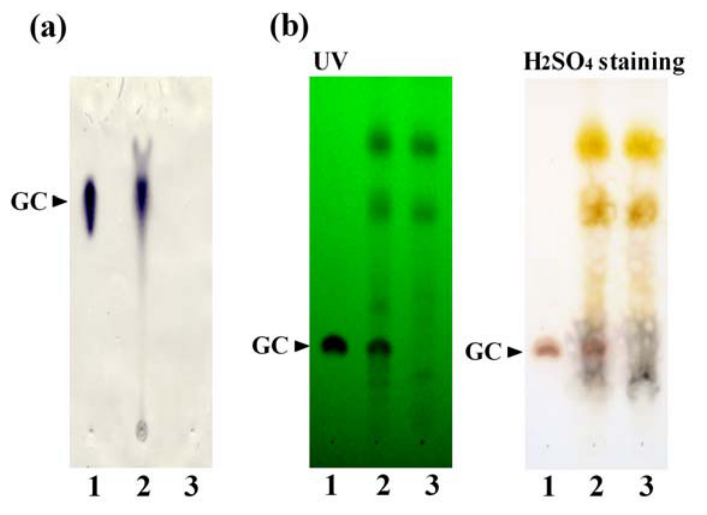
Figure 5. ( a ) Eastern blotting using anti-GC mAb and ( b ) TLC profiles of the